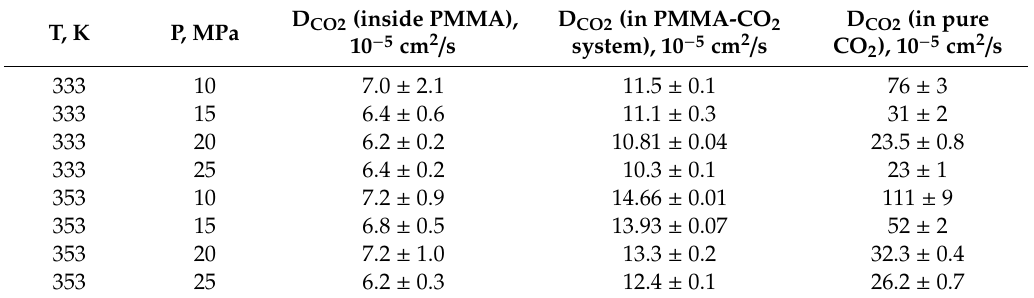
Table 6. Di ff usion coe ffi cient of CO 2 inside PMMA, in the PMMA-CO 2 system, and in pure sc-CO 2 . T, K P,